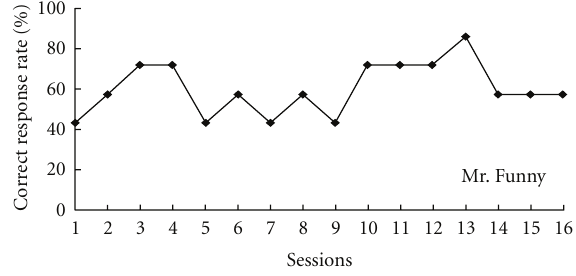
Figure 9: Correct response rates over sessions for successive visi- bility. The correct response rates were calculated as the percentage of “attempt made” trials when the remainder was 2 and 1, and “attempt not made” trials when the remainder was 0, over the total 7 trials for each